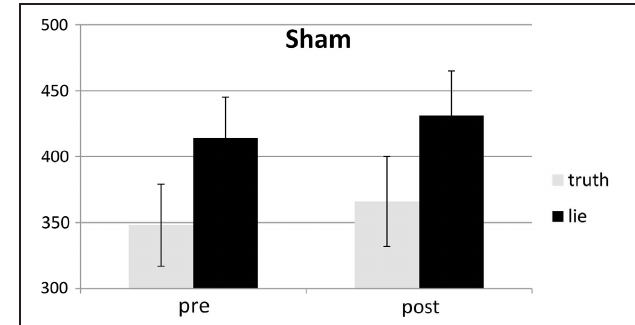
FIGURE 7 | Mean SDs of RTs (ms; ± one SE) for lie and truth trials, pre and post